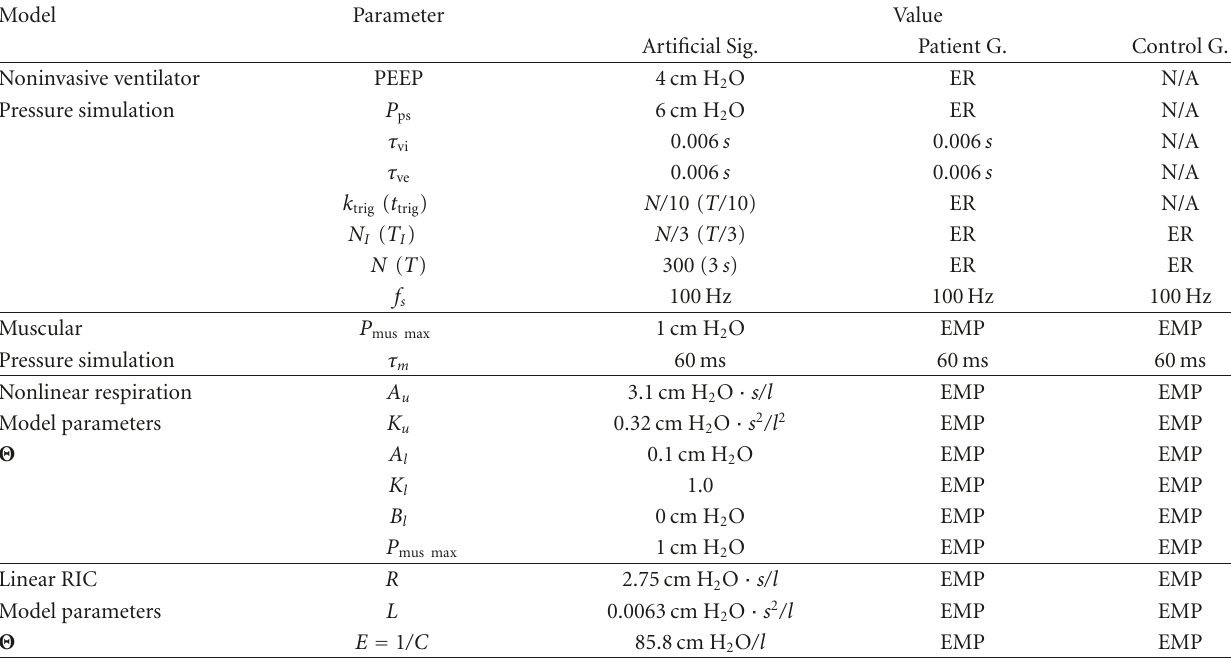
Table 1: Parameters of the respiratory signals in the simulations. ER and EMP stand for experimental reading and estimated model parameter,